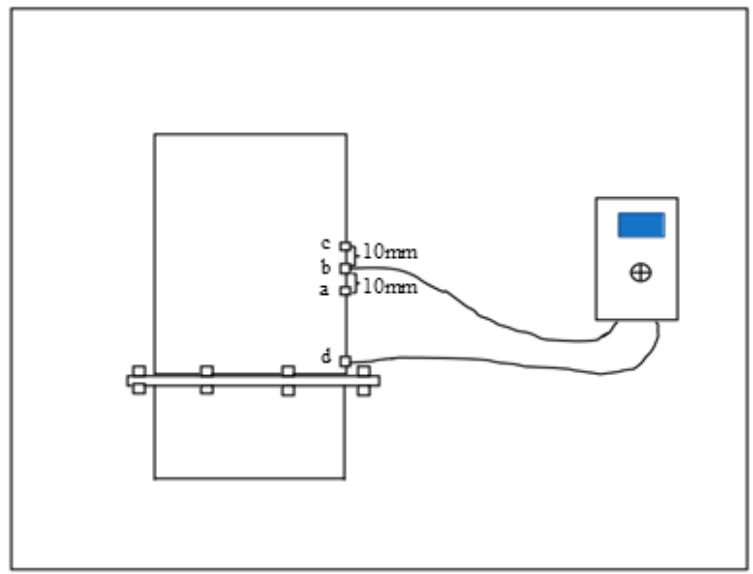
Figure 2. Pressure measurement